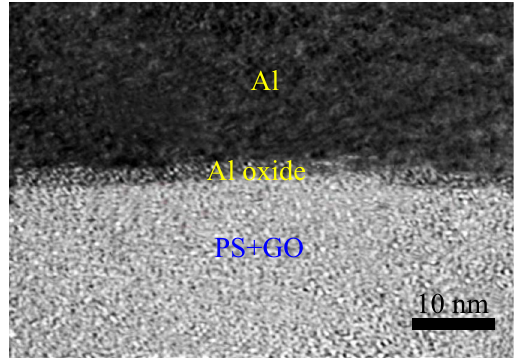
Figure 8. The cross-sectional HRTEM images of ITO/PS + GO/Al structures.